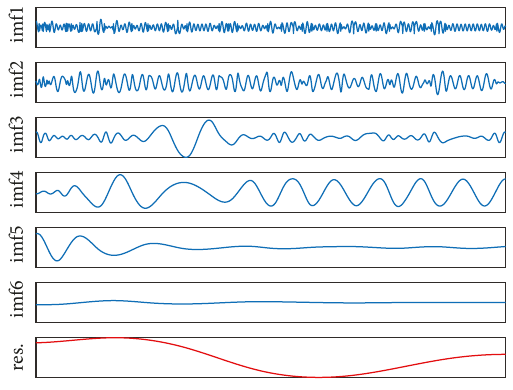
Figure 8: Results of signal decomposition by